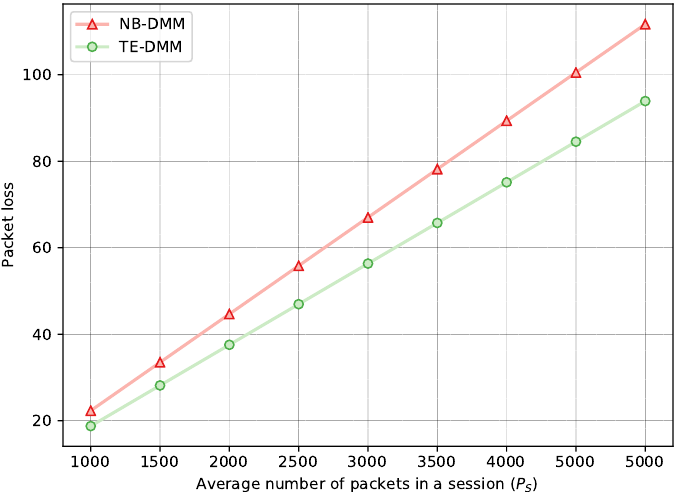
Figure 9. Packet loss depending on number of of